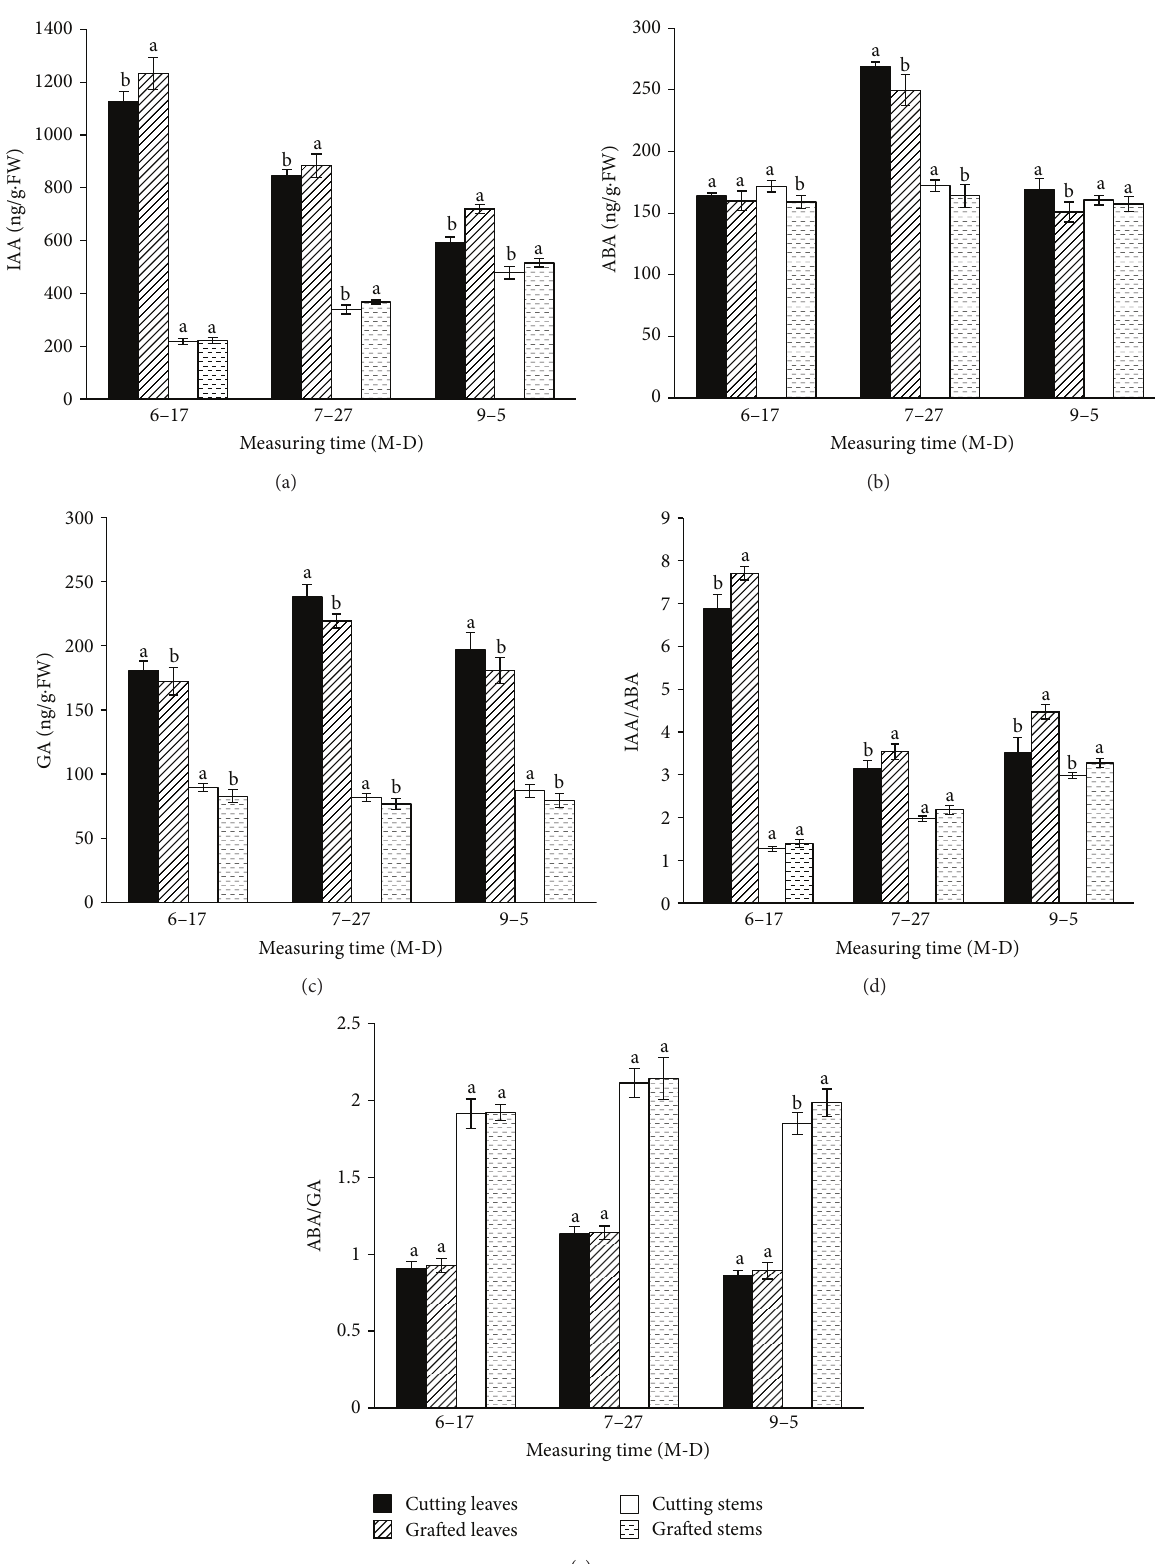
Figure 3: The contents of IAA, ABA and GA and the IAA/ABA and ABA/GA ratios in the nongrafted and grafted cuttings “Jinba”. H1: cuttings harvested on June 17; H3: cuttings harvested on July 27; H5: cuttings harvested on September 5; means and standard errors calculated from three replicates. Significance ( 𝑃 < 0.05 ) indicated by lower case lettering ((a), (b)), derived using the Duncan’s multiple range